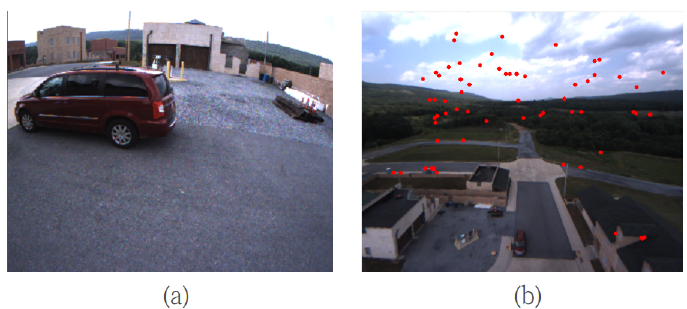
Figure 2. Short-range and long-range environments. ( a ) Short-range environment. In this situation, most of the features are directly triangulated by static stereo baseline. ( b ) The long-range environment can also detect some large disparities of “short-rang” features (red dot) due to incorrect matching for the repetitive texture area. For this case, most of the "short-range” features are outliers; thus, they cannot be directly triangulated by static stereo baseline.